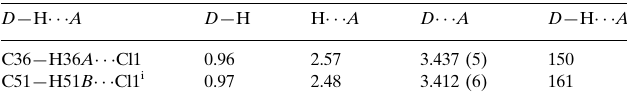
Hydrogen-bond geometry (A˚ , (cid:3)